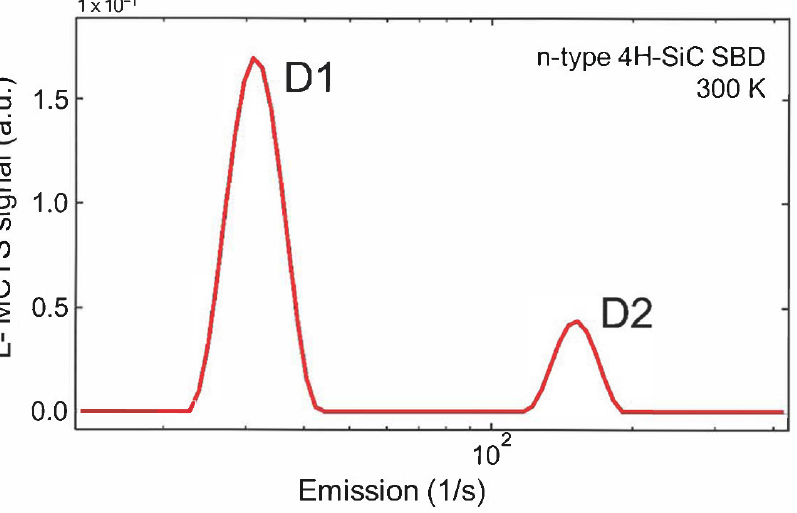
Figure 8. L-MCTS spectrum for D-center in then-type 4H-SiC SBD measured at 300 K. Data adapted from Ref. [15].